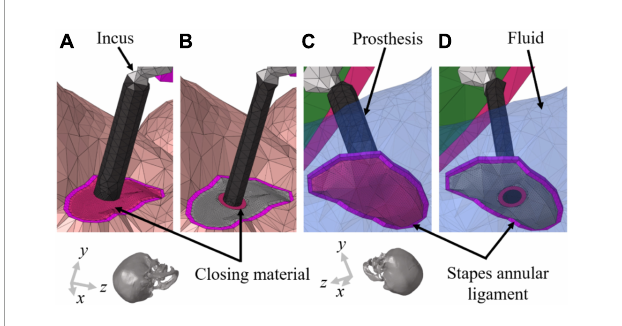
FIGURE2 Geometrical illustrations of the stapedectomy and stapedotomy in the right ear of finite-element (FE) models. (A) To implement stapedectomy, the entire stapes was removed, and the closing material was filled in the space from which the stapes footplate was removed and a prosthesis ( ϕ = 0.6 mm) connecting the end of the incus to the center of the closing material was added. (B) The stapedotomy involved placing a hole ( ϕ = 0.6 mm) in the stapes footplate to insert the prosthesis ( ϕ = 0.4 mm); the stapes footplate and prothesis are connected by the closing material. Near the stapes footplate, the cochlear fluid is in contact with (C) only the closing material in stapedectomy, whereas the fluid in the stapedotomy is in contact with (D) the end of the prosthesis, stapes footplate, and closing material. The transparent blue elements in (C,D) represent cochlear fluid.